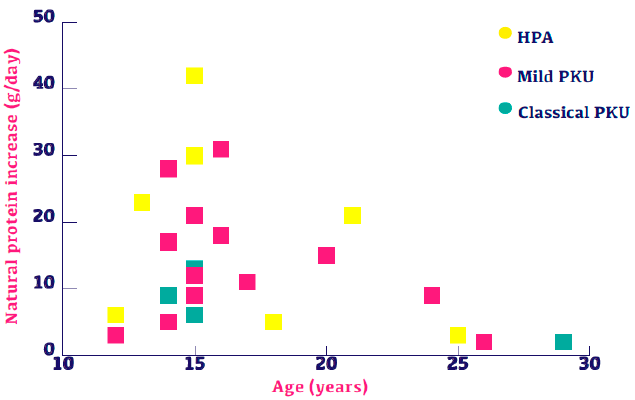
Figure 2. Twenty-six subjects with increased natural protein presented by age and severity of disorder.